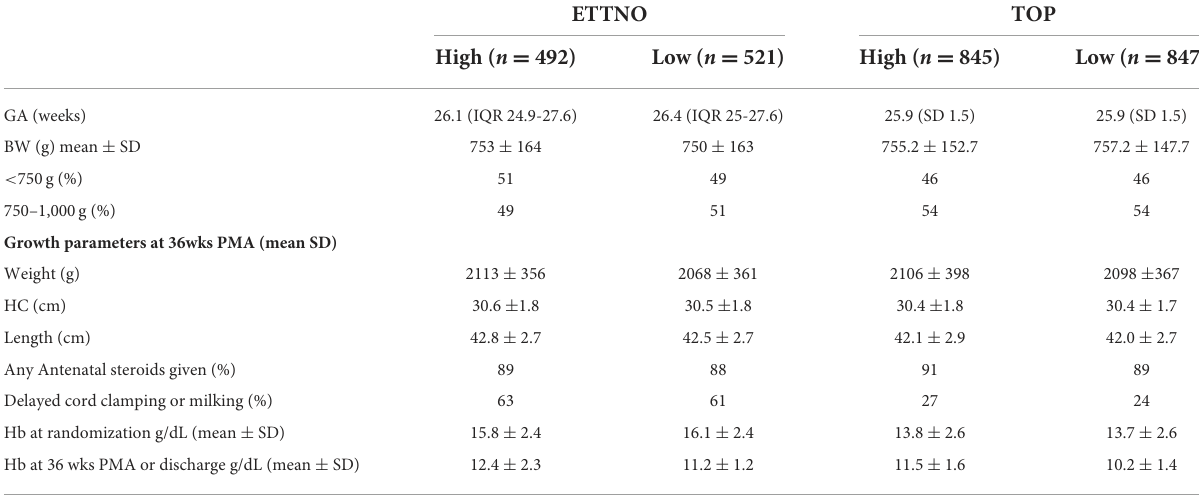
TABLE 1 Comparison between ETTNO and TOP trials and between high and low threshold groups at randomization and 36 weeks post menstrual age (PMA). ETTNO TOP High ( n = 492)